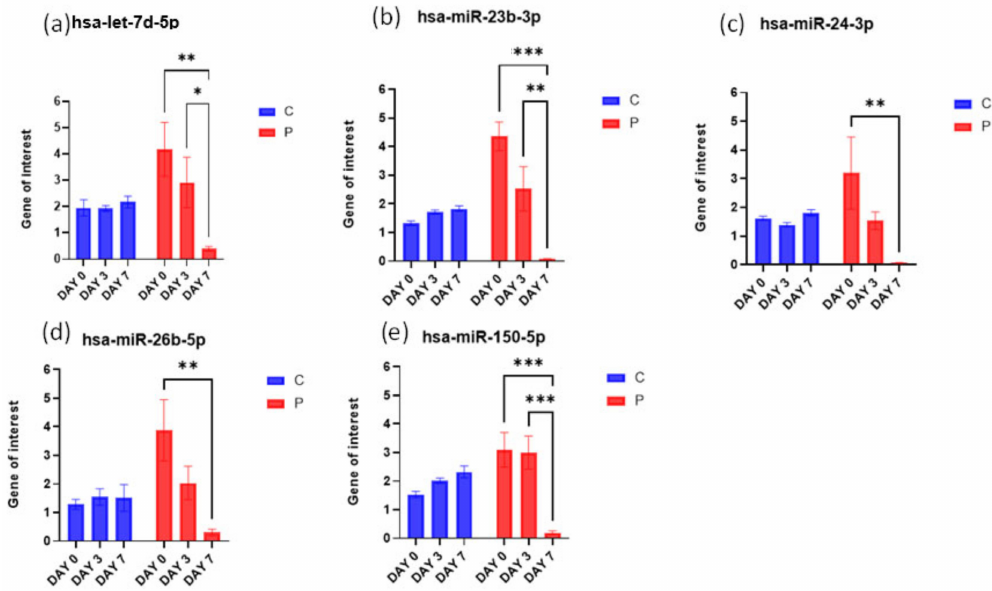
Figure 6. Real-time qPCR results. let-7d-5p, miR-23b-3p, miR-24-3p miR-26b-5p and miR-150-5p expression in peripheral blood leukocytes were compared within the control group ( n = 3) and patient group ( n = 3). Expression was normalized to the expression of miR-423-5p. Mean fold change (for each person) in three independent quantitative PCRs is shown. * p < 0.05, ** p < 0.01, *** p < 0.001 (two-tailed t -test).